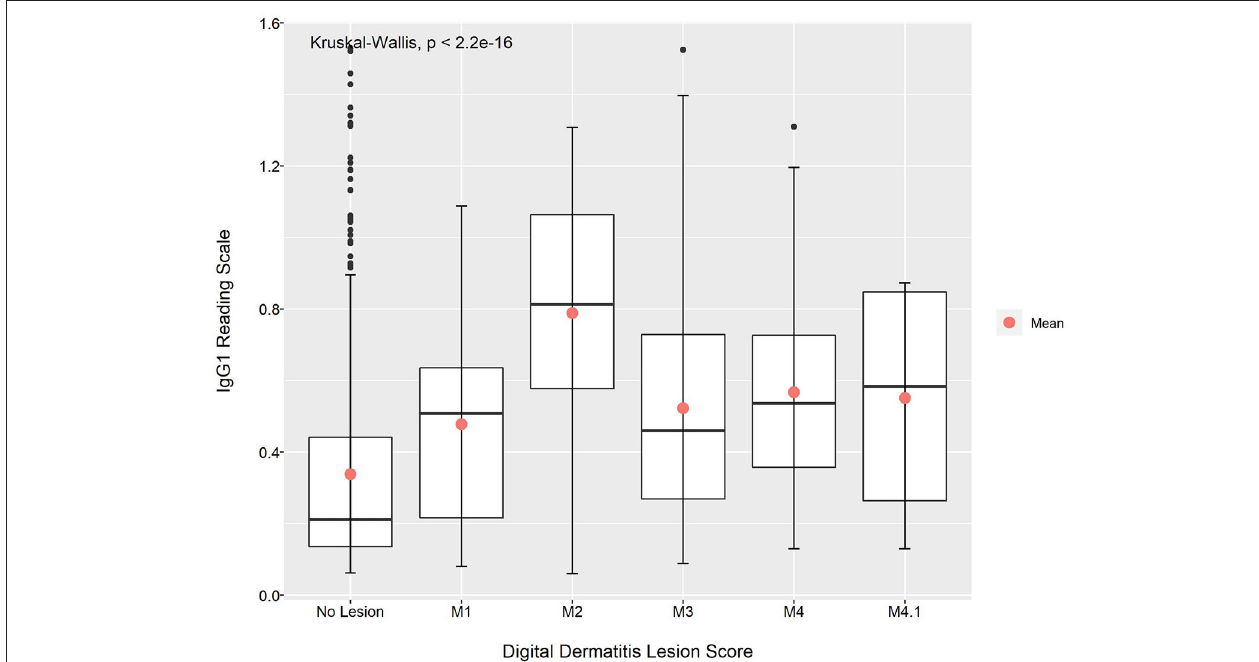
FIGURE 1 | Mean absorbance reading for IgG1 anti- Treponema antibodies across the different DD lesion scores.